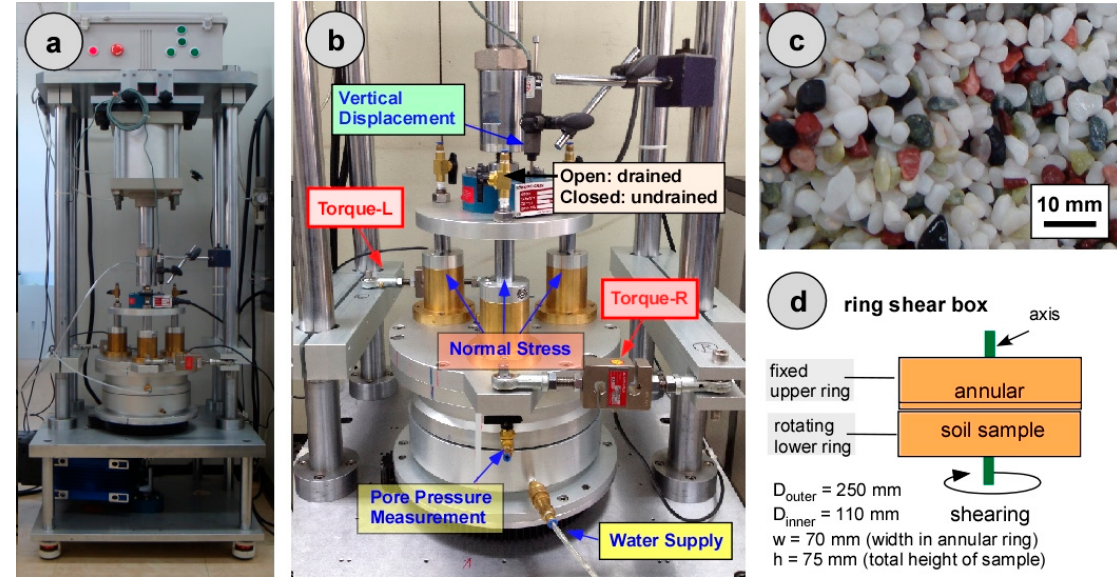
Figure 1. Ring shear apparatus and material: ( a ) Ring shear apparatus; ( b ) ring shear box; ( c ) gravel; and ( d ) schematic view of ring shearing.